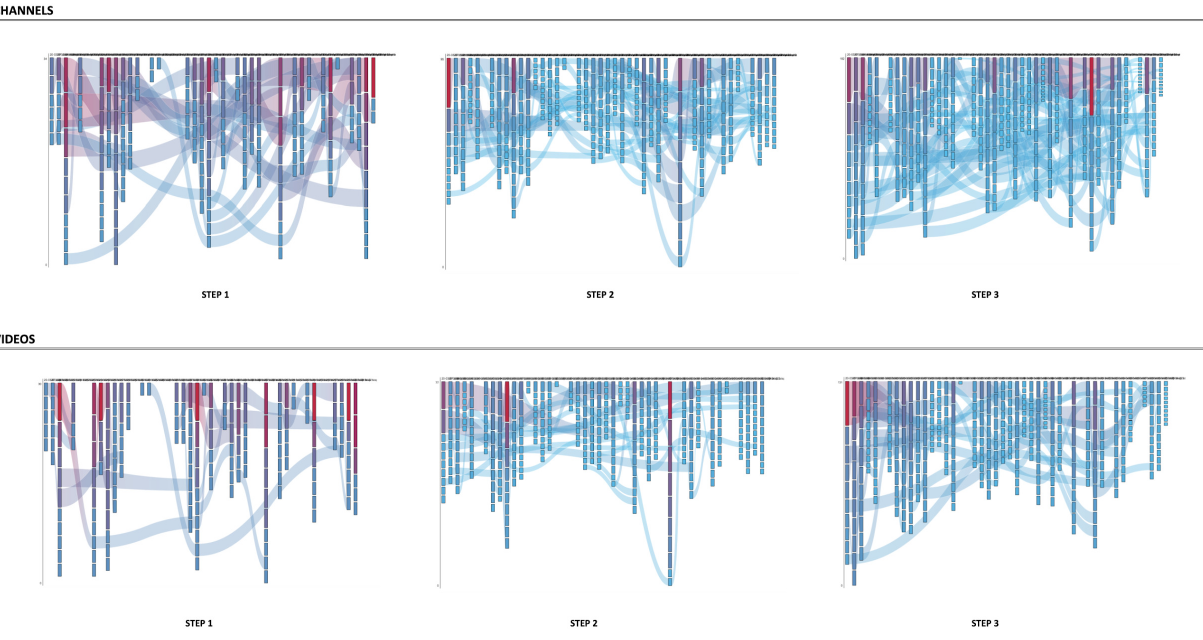
Media and Communication, 2021, Volume 9, Issue 4, Pages